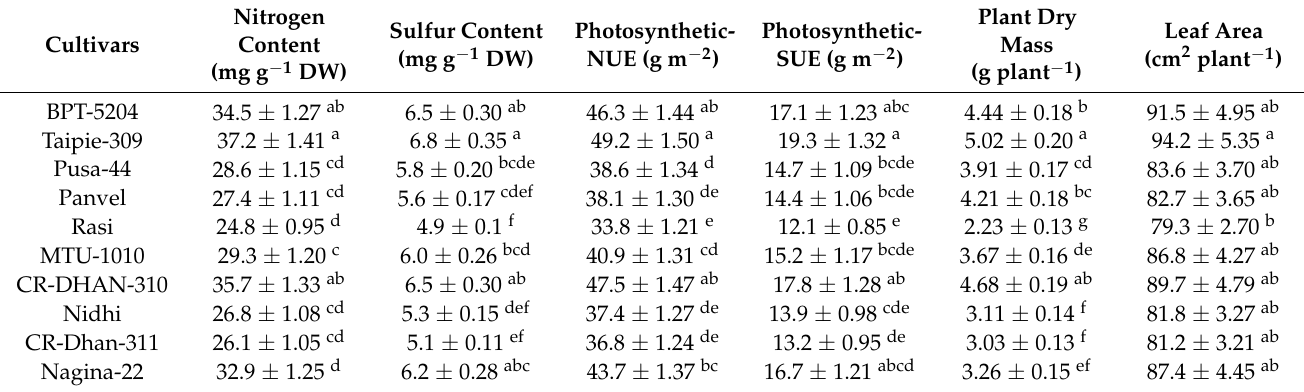
Table 1. Leaf nitrogen and sulfur content, photosynthetic nitrogen-use efficiency (NUE), photosynthetic sulfur-use efficiency (SUE), plant dry mass, and leaf area in cultivars of rice ( Oryza sativa L.) at 30 days after germination (DAG).